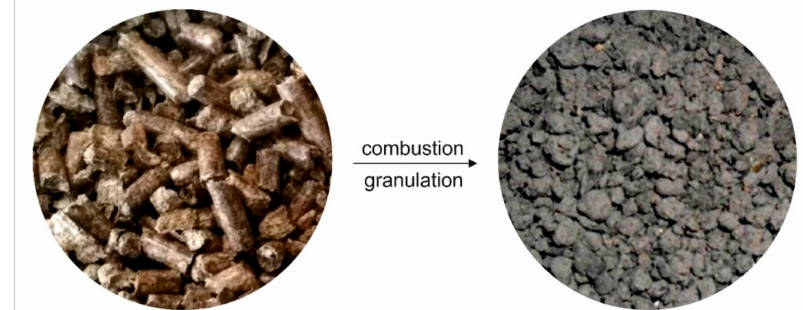
Figure 1. Biomass pellet and the granulate produced from the bottom ash after biomass combustion (775 g ash + 225 g